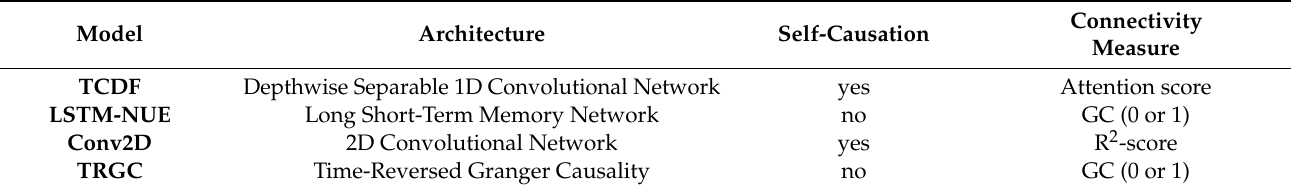
Table 1. Set-up of the compared ANNs and